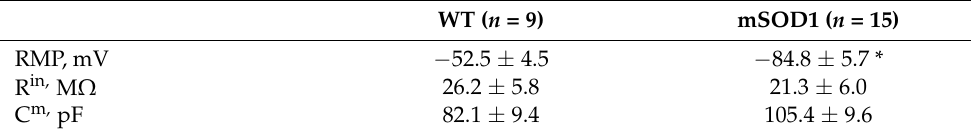
Table 2. Basic membrane properties of MesV in a 12-week-old mouse model of